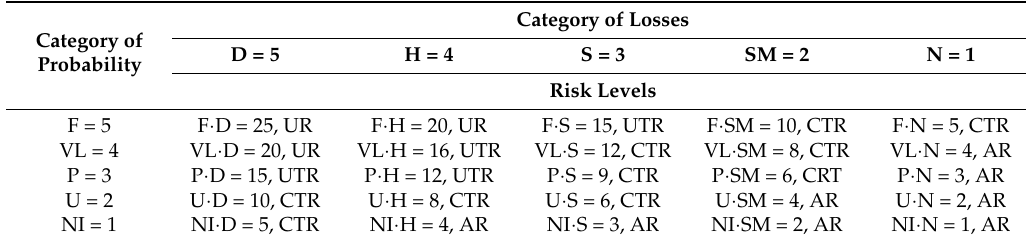
Table 6. Risk matrix.